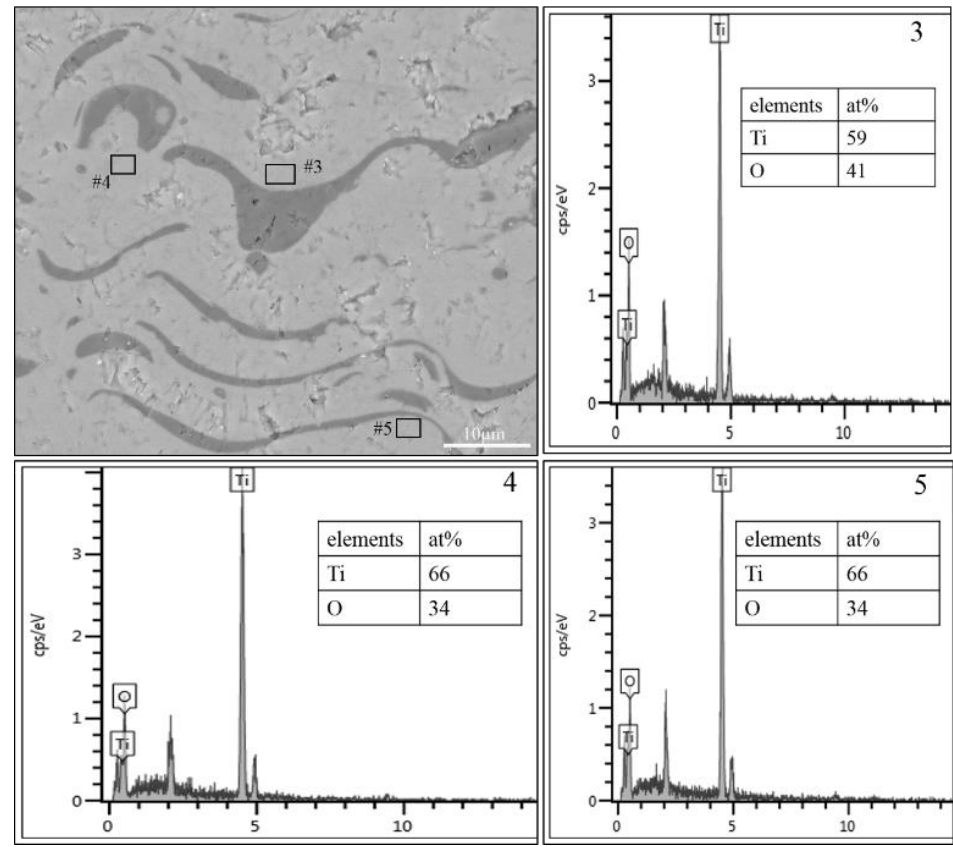
Figure 5. Backscatter electron imaging of TiO 2 -15MgAl 2 O 4 coating and EDS analysis.